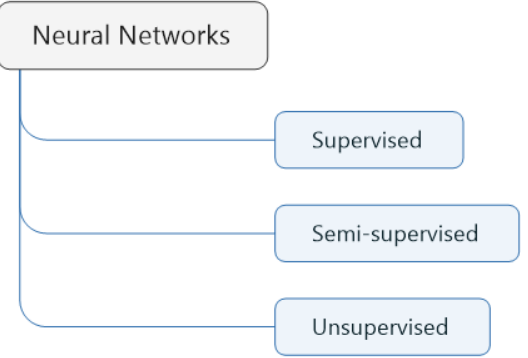
Figure 3. Neural networks classification by the learning